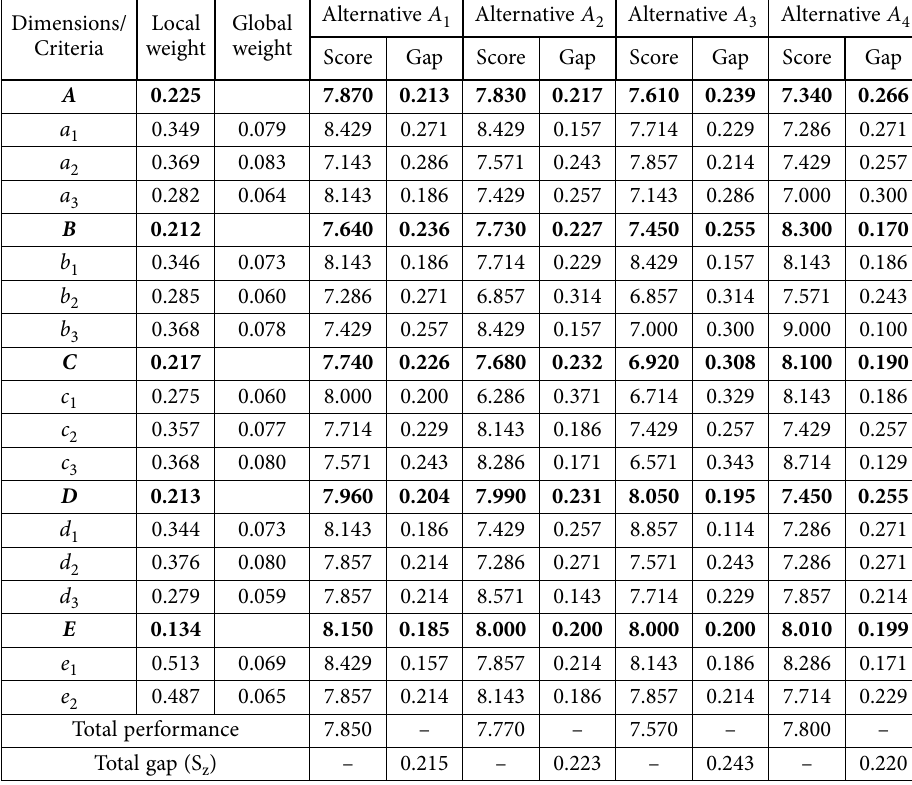
Table 7. Gap-ratio value of AI-enabled audit for Big 4 CPA firms by modified-VIKOR Dimensions/